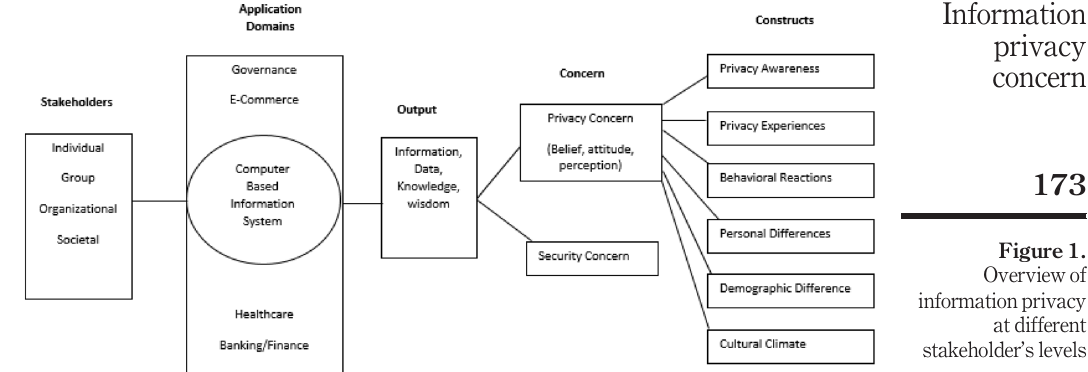
Figure 1. Overview